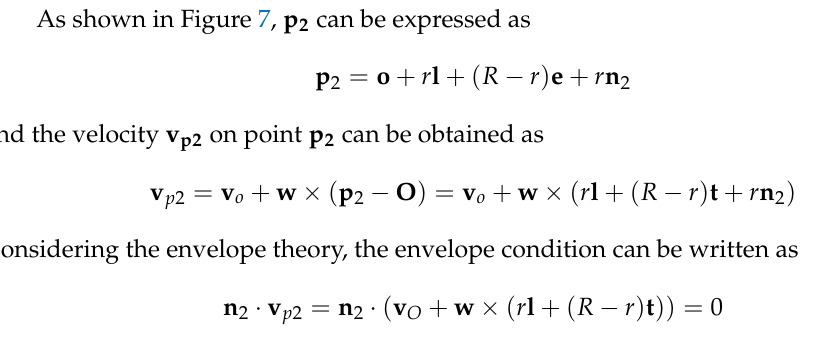
Figure 7. Calculating the contact point on the filleted end mill